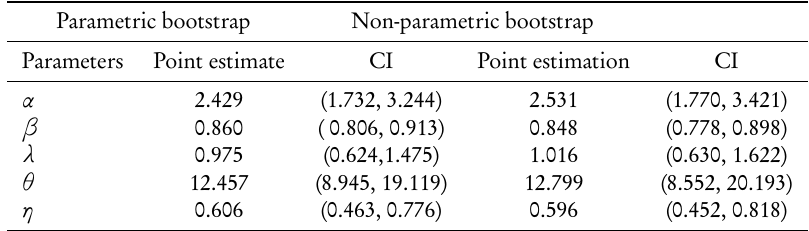
Bootstrap point and interval estimation of the parameters α , β , λ , θ and η for the first data set.